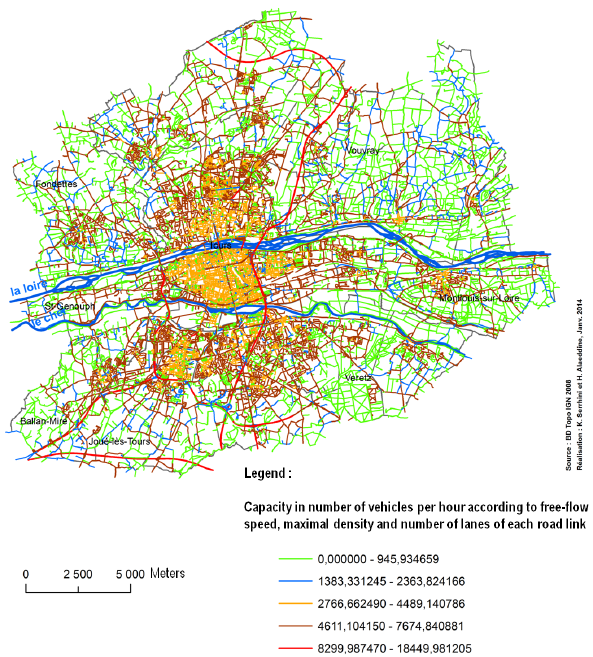
Figure 8. Capacity of roads according to free-flow speed, jam den- sity and number of lanes on